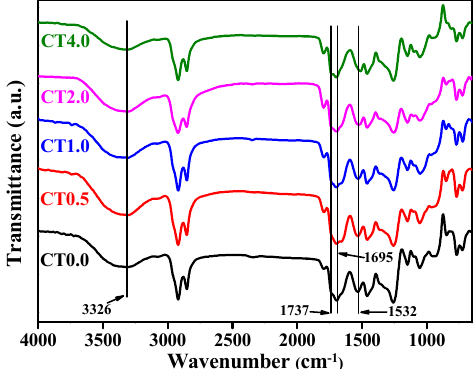
Figure 7. ATR-FTIR of NIPU Composite Film. Table 3. Thermal Degradation Data of NIPU